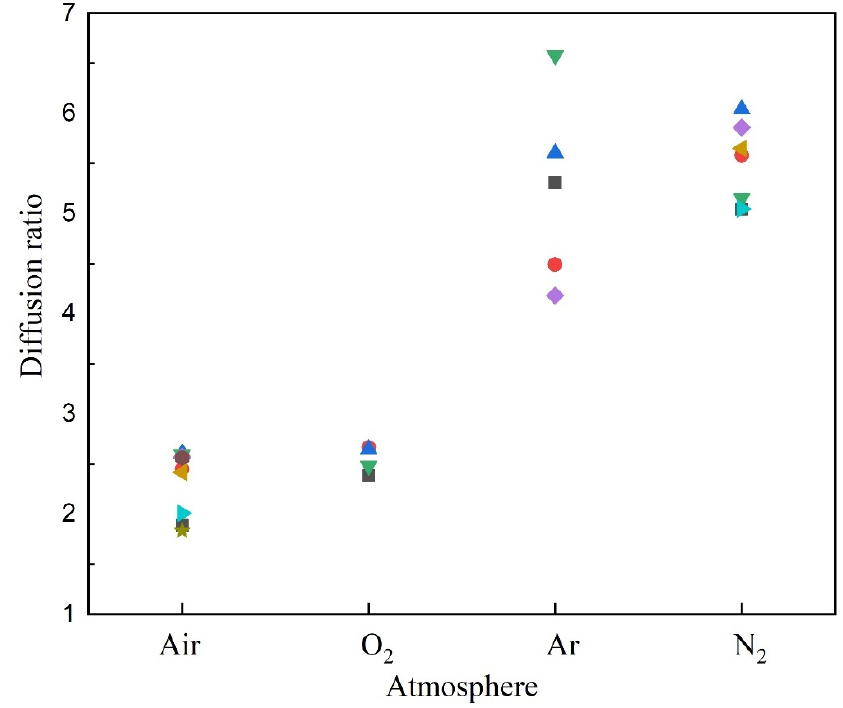
Figure 11. Diffusion ratios of Mg microparticles burned in inert and oxidizing atmospheres. Table 2. The content of elements in combustion residues of individual Mg microparticles.